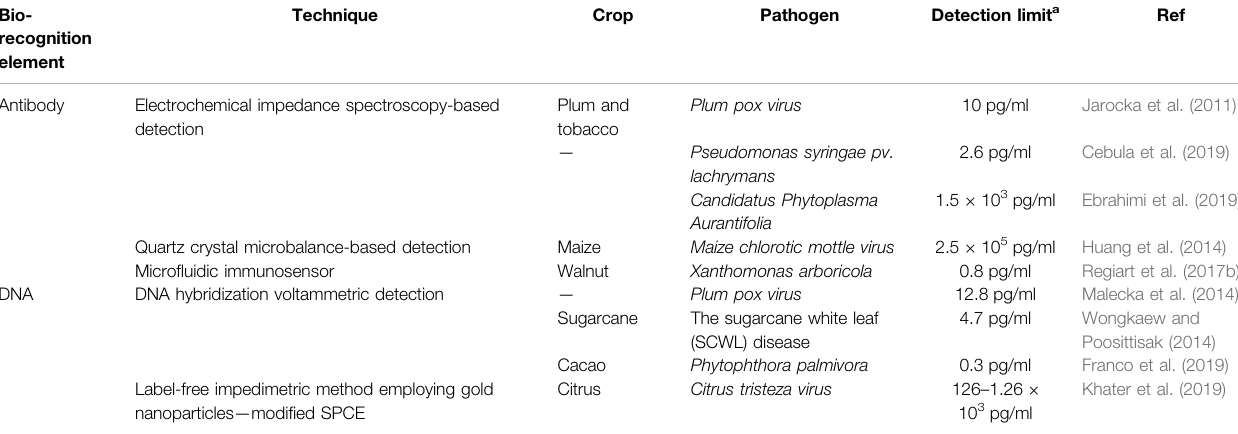
TABLE 1 | Examples of electrochemical biosensors developed for the detection of plant